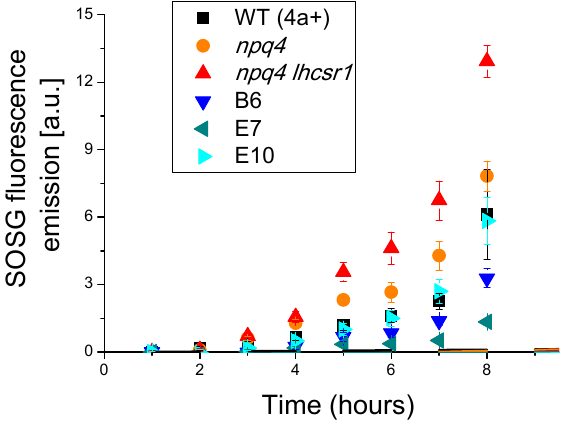
Figure 6. Singlet oxygen production for WT and transformed lines. Singlet oxygen production was estimated from fluorescence emission of Singlet Oxygen Sensor Green (SOSG) probe. Data reported are the mean values of three independent biological replicates with standard deviations indicated as error bars.